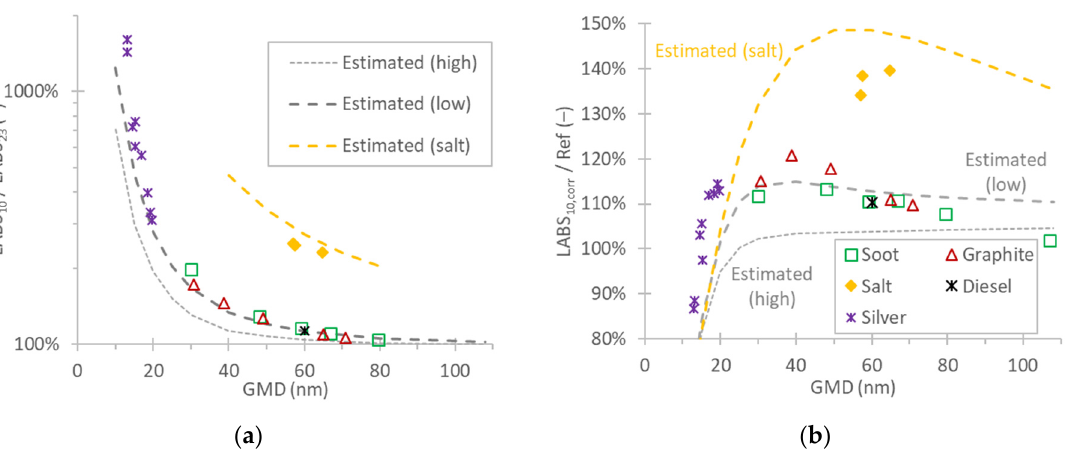
Figure 9. Comparison of estimated and measured data for polydisperse aerosol: ( a ) ratio of 10 nm to 23 nm systems; ( b ) corrected 10 nm system concentration to reference. Note that the legend is split in the two panels.